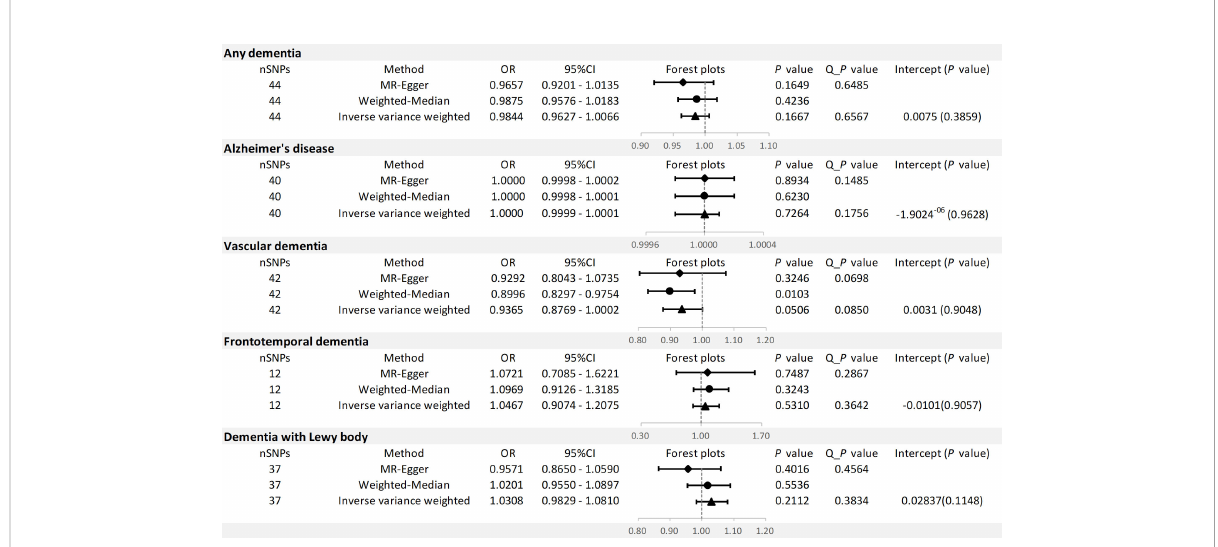
FIGURE 3 MR results and sensitivity analysis for association of SLE and dementia risk.